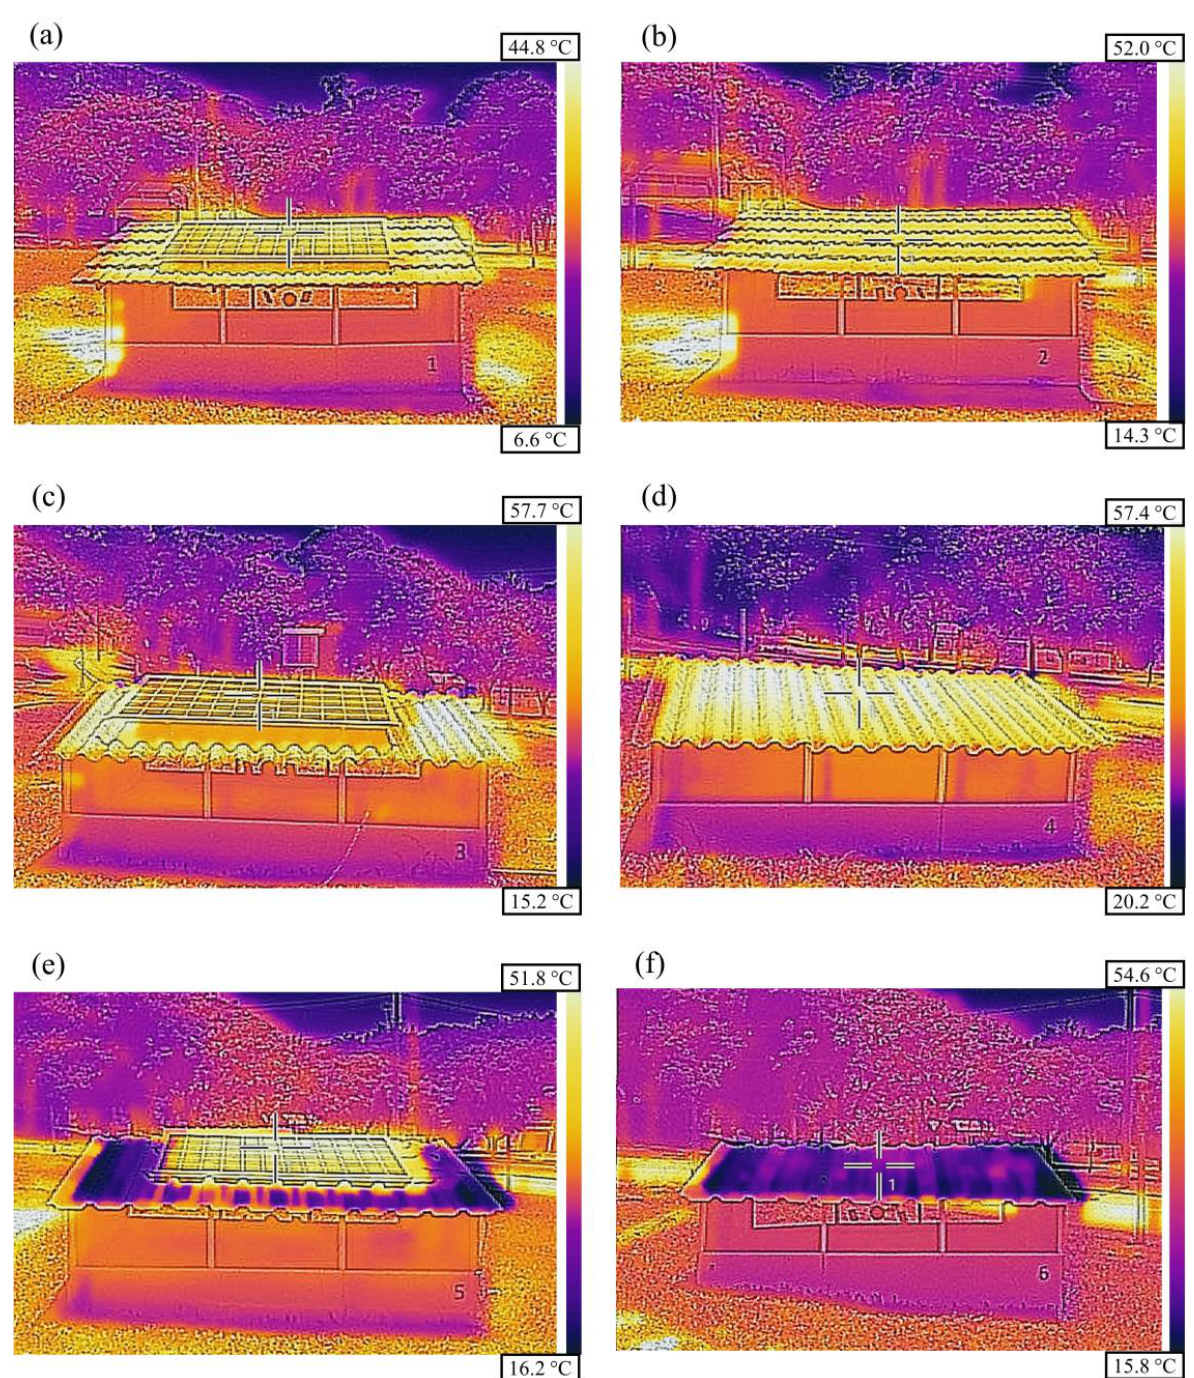
Figure 4. Infrared thermography of the prototypes at 12:00 h: ( a ) ceramic tile with photovoltaic panel; ( b ) ceramic tile; ( c ) fiber-cement tile with photovoltaic panel; ( d ) fiber-cement tile; ( e ) metallic tile with photovoltaic panel; and ( f ) metallic tile.